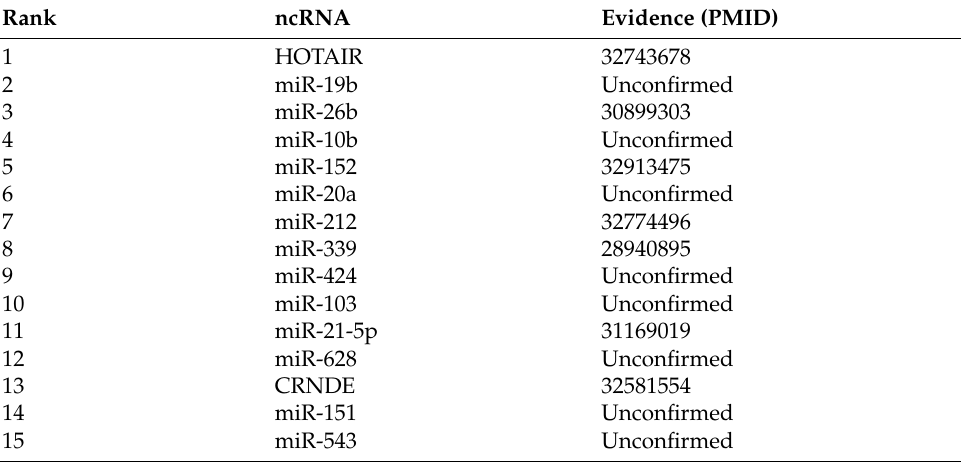
Table 6. The top 15 miRNAs related to Paclitaxel resistance predicted by